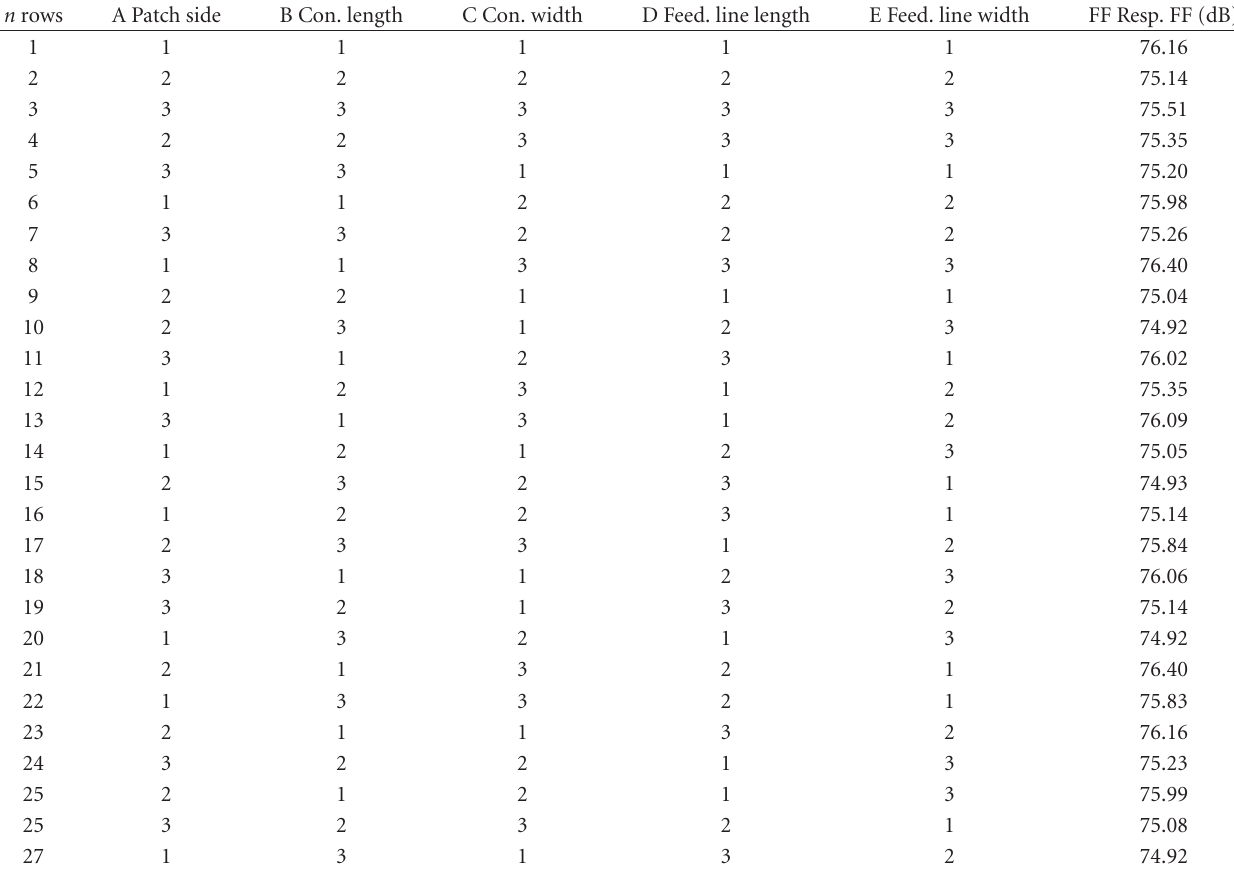
Table 2: The OA 27 5 3 as configured with the parameters levels and the responses of the final FF.